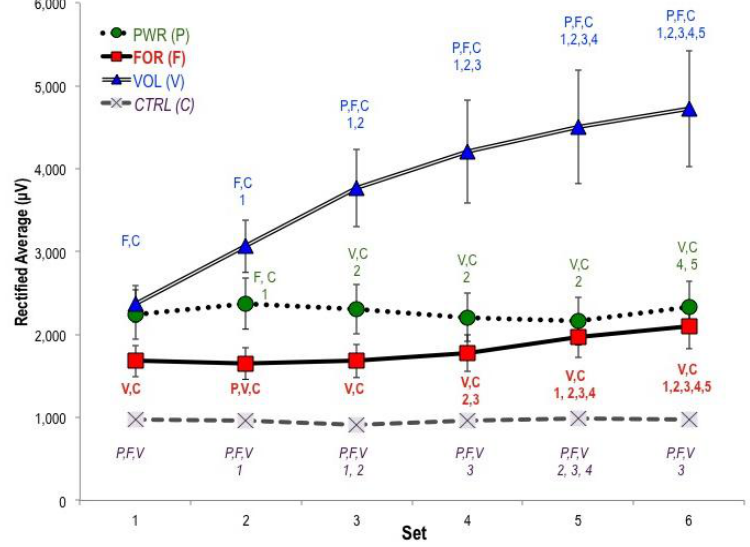
Figure 2. Changes in sensory activity (CP3, CPZ, CP4) across six sets. Sensory activity was especially pronounced in the PWR protocol (30% 1RM jump squats) initially but was rapidly overwhelmed by VOL. Pairwise differences are indicated in the form X:Y , indicating Reference Protocol: Significantly Different Protocol . “F” indicates the FOR protocol, “V” VOL, and so forth. In a given protocol, “1” indicates the value is significantly different from Set 1 of that protocol, “2” from Set 2, and so